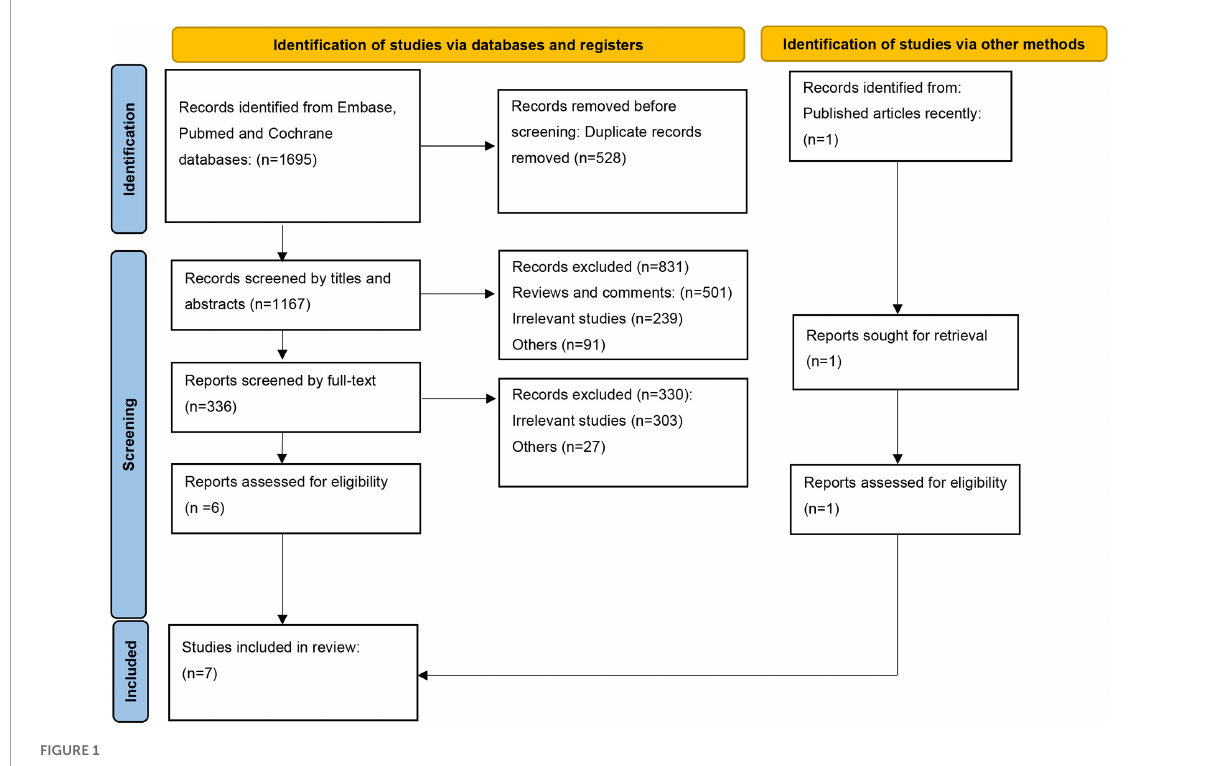
FIGURE1 Search flow